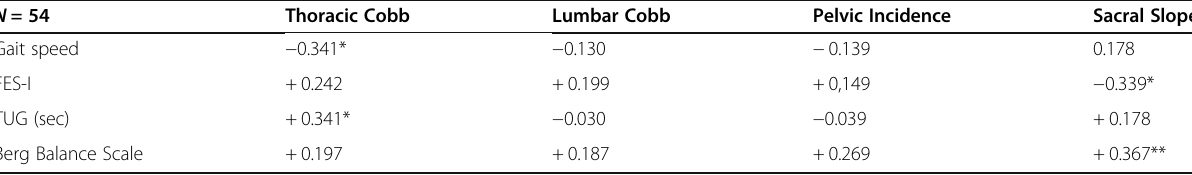
Table 2 Correlations of spine and pelvis angles with FES-I and performance tests N = 54 Thoracic Cobb Lumbar Cobb